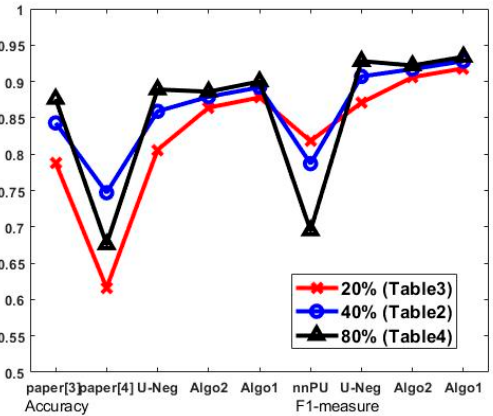
Figure 2. The comparison of average accuracy and F1-measure of the MPU and PU learning methods varying the size of unlabeled negative data samples.